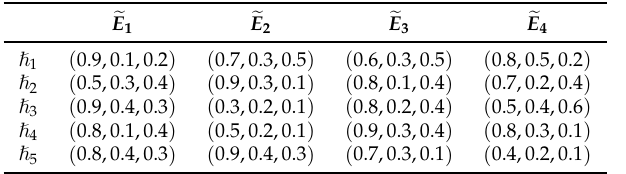
Table 1. FOF β —covering (cid:101) E in Example 1.